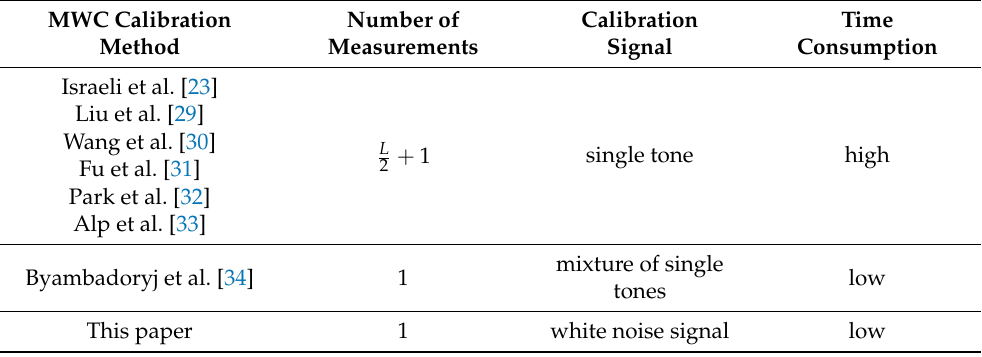
Table 1. Comparison between our MWC calibration method and others MWC calibration methods from the